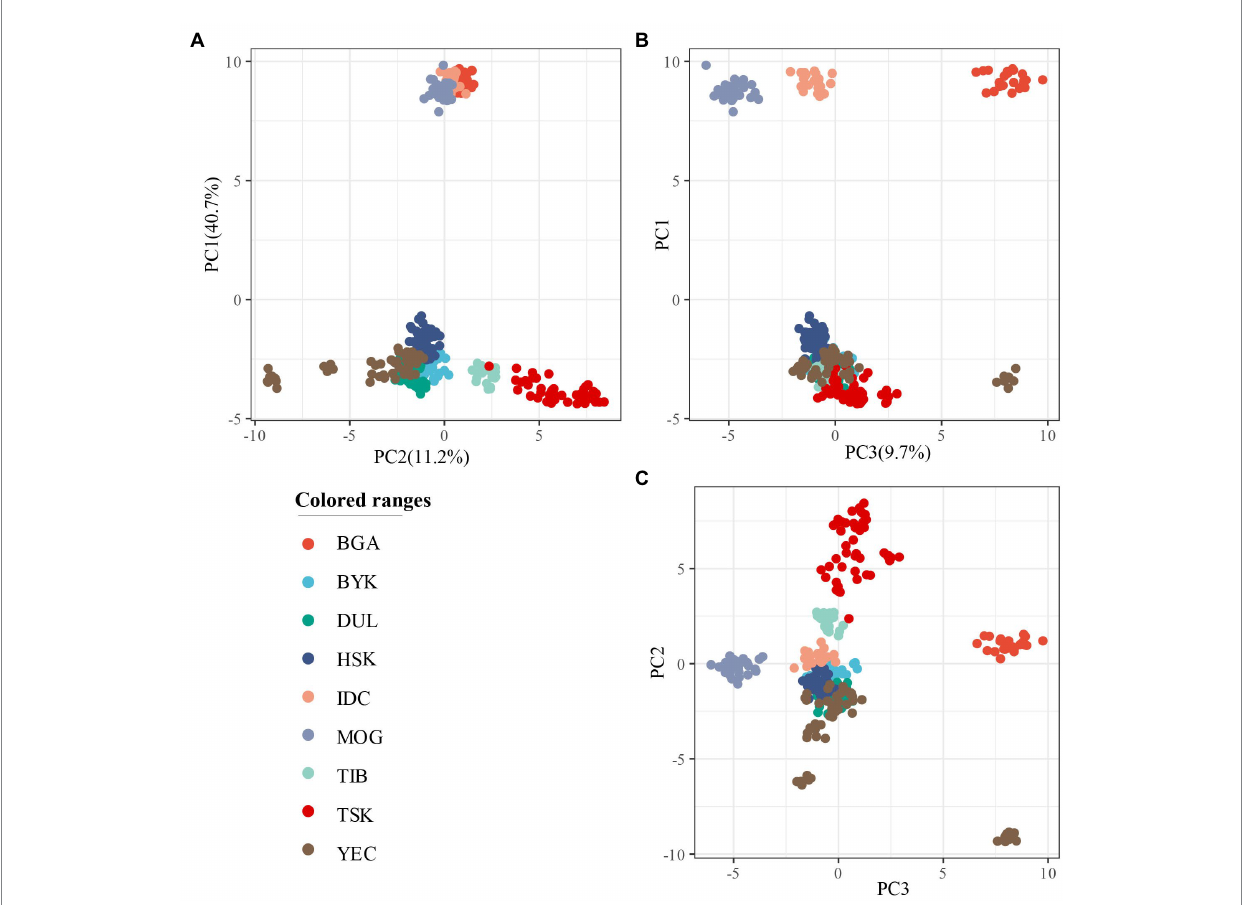
FIGURE 1 Principal component analysis of nine sheep breeds. The analysis was performed for the first two components (C1 and C2) (A) , for the first and third component (C1 and C3) (B) and for the second and third component (C2 and C3) (C)